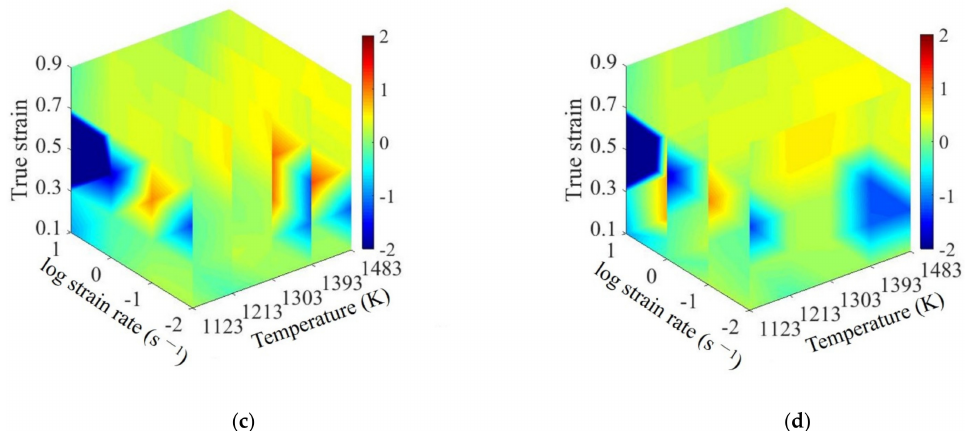
Figure 9. 3D flow instability map: ( a ) three-dimensional body; ( b ) strain section; ( c ) temperature section; ( d ) strain rate section.